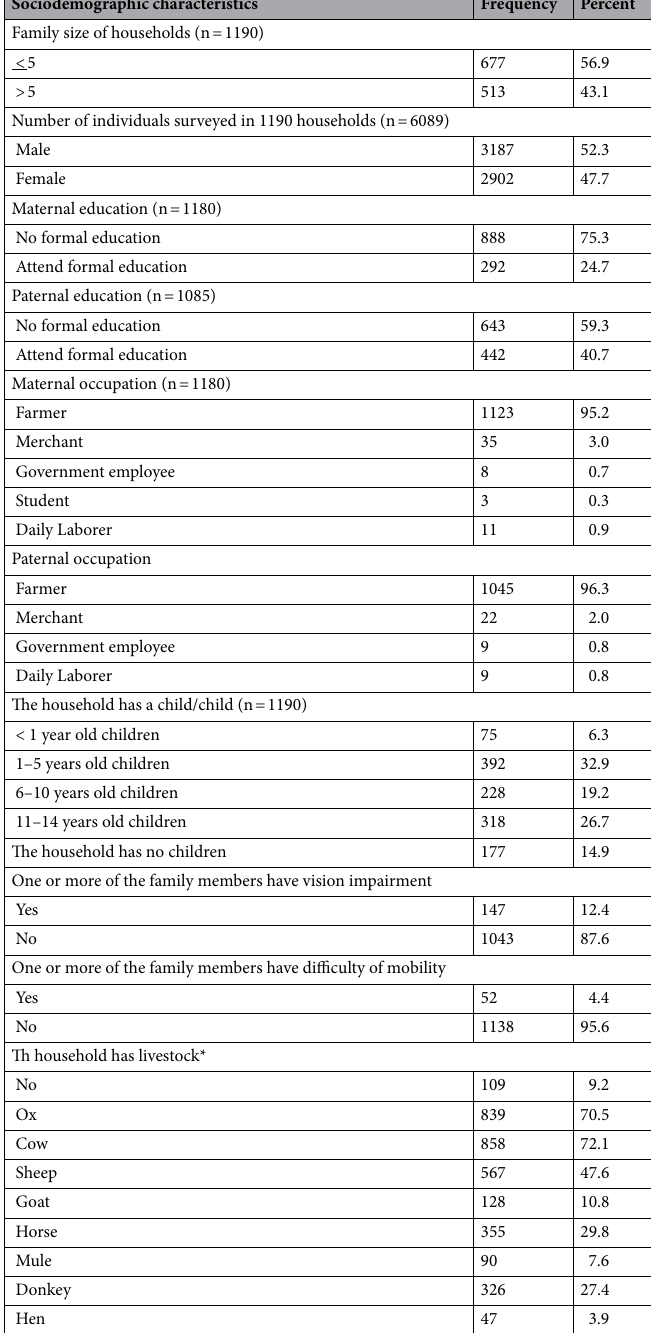
Table 1. Sociodemographic characteristics of households (n = 1190) in a rural setting of northwest Ethiopia, May 2016. *Households had two or more